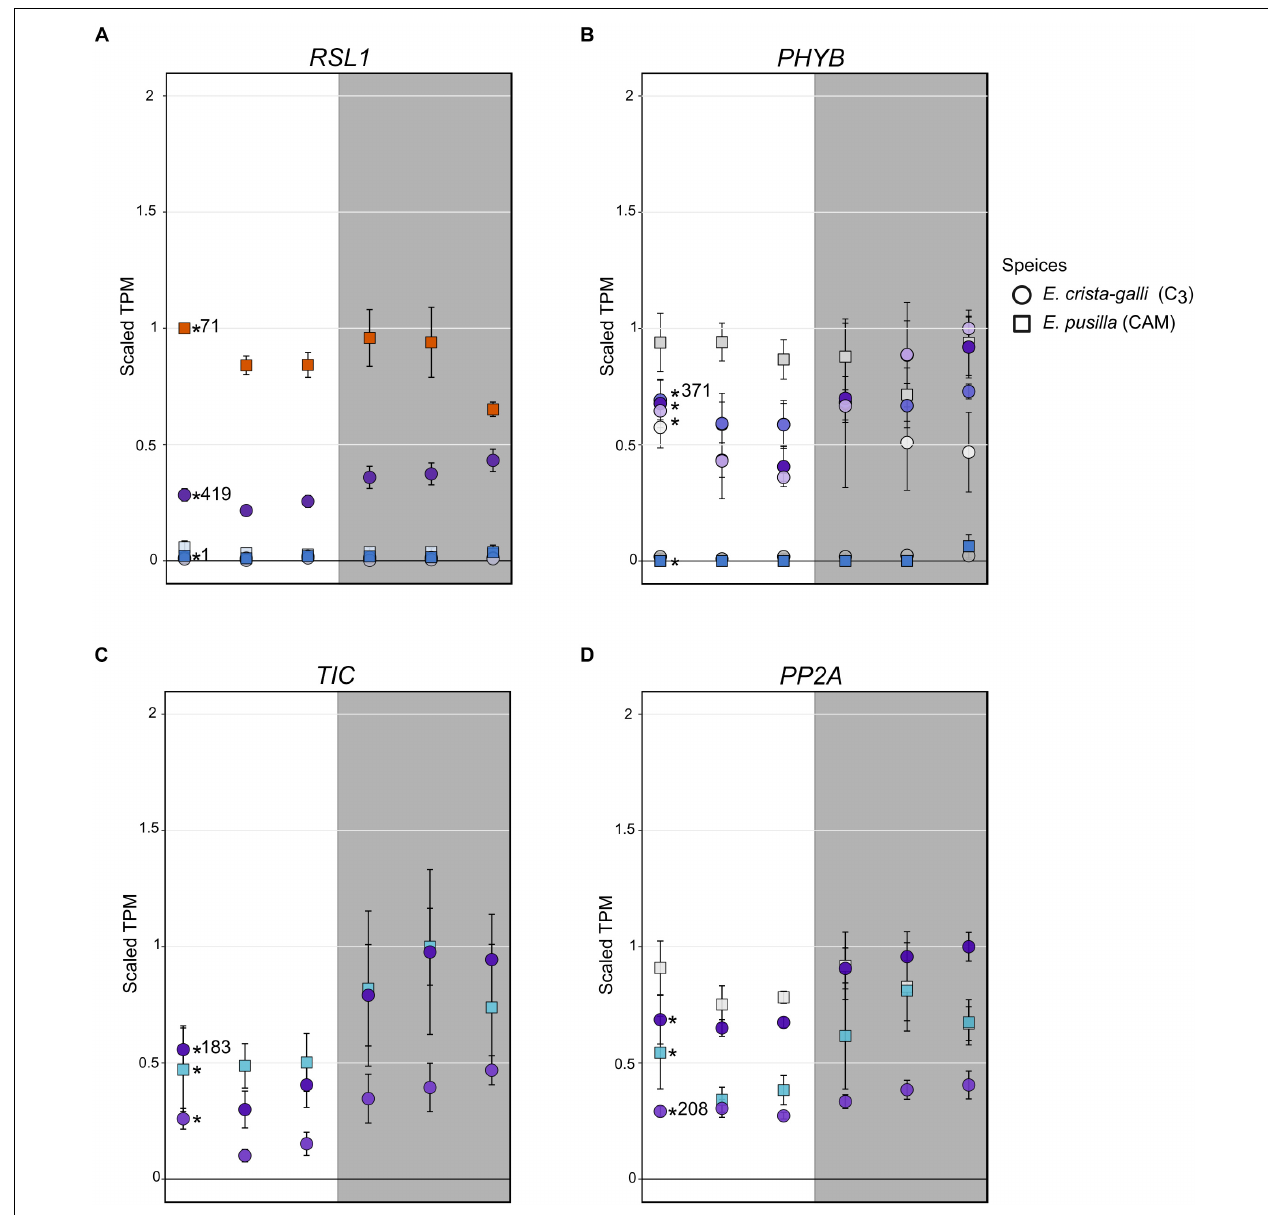
FIGURE 6 | Expression of (A) ring finger of seed longevity 1 (RSL1), (B) phytochrome B/D (PHYB), (C) time for coffee (TIC), and (D) protein phosphatase 2A in E. pusilla (squares) and E. crista-galli (circles). Points are colored by which category of cluster they belong to: blues and purples are genes with increases in expression in the dark in E. pusilla and E. crista-galli , respectively, while oranges and yellows are genes with increases in daytime expression in E. pusilla and E. crista-galli , respectively (see Figure 3 ). Time-structured genes are marked with an asterisk, while those that were not significantly time-structured are shown in gray. Number of directed edges per gene is shown if they belonged to the RSL1 subnetwork. Average TPM and standard deviation, scaled to the maximum mean TPM value across all copies and species, are plotted for all six time points, with the gray background indicating nighttime